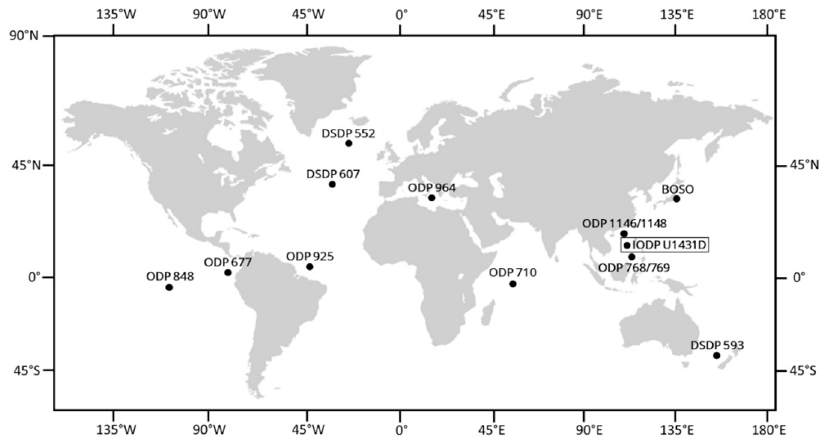
Figure 7. Location of DSDP/ODP/IODP Sites used in this study for comparison of Pleistocene Figure7. LocationofDSDP / ODP / IODPSitesusedinthisstudyforcomparisonofPleistocenenannofossil nannofossil datums. Site IODP 1431 is examined in the present study. datums. Site IODP 1431 is examined in the present